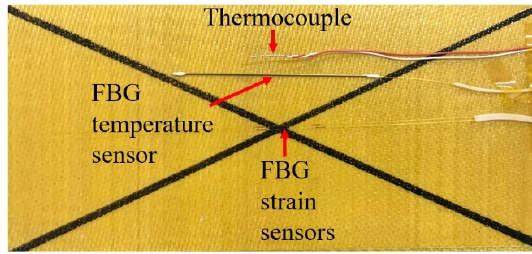
Figure 5. Distributions of FBGs and thermocouple.